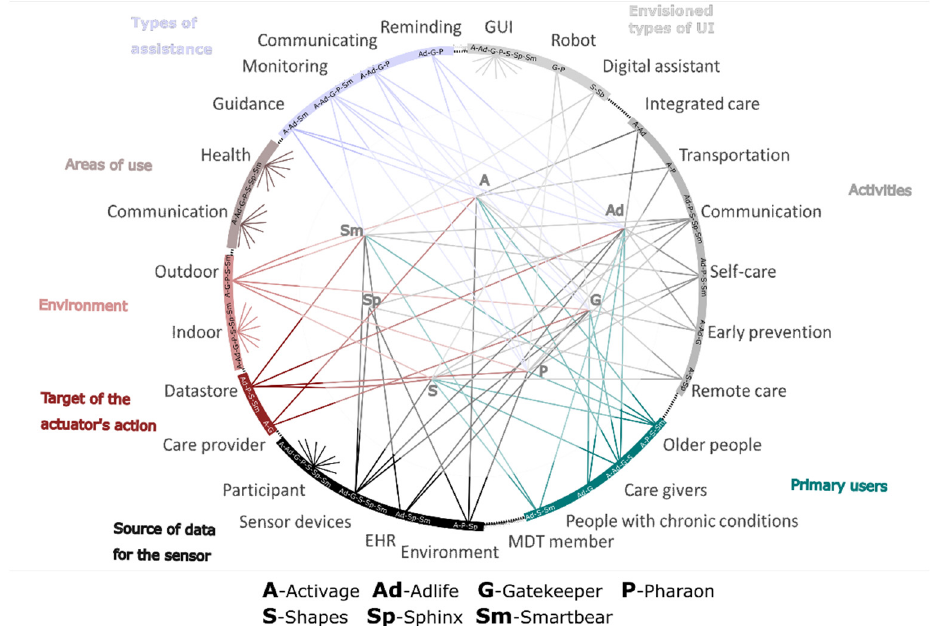
Figure 6. PHS taxonomy-based classification commonalities in a nutshell.